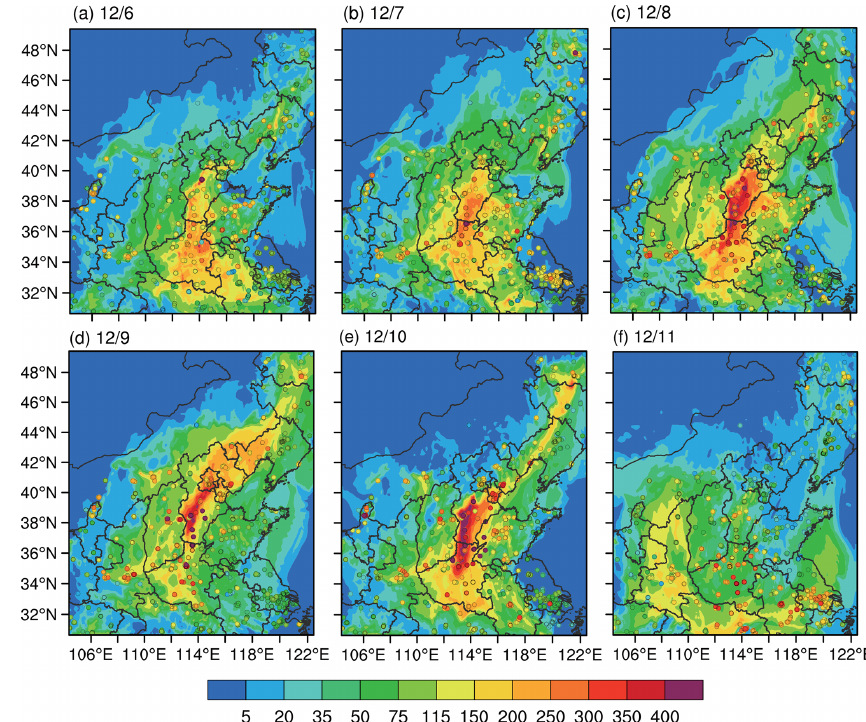
Figure 5. Observed (colored dots) and WRF-Chem simulated (shadings) spatial distribution of PM 2 . 5 concentrations (µgm − 3 ) at 08:00LT on (a) 6 December, (b) 7 December, (c) 8 December, (d) 9 December, (e) 10 December and (f) 11 December.